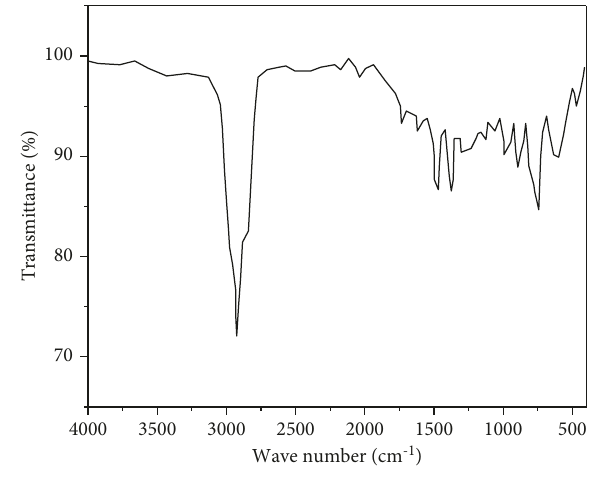
Figure 4: FT-IR analysis of the